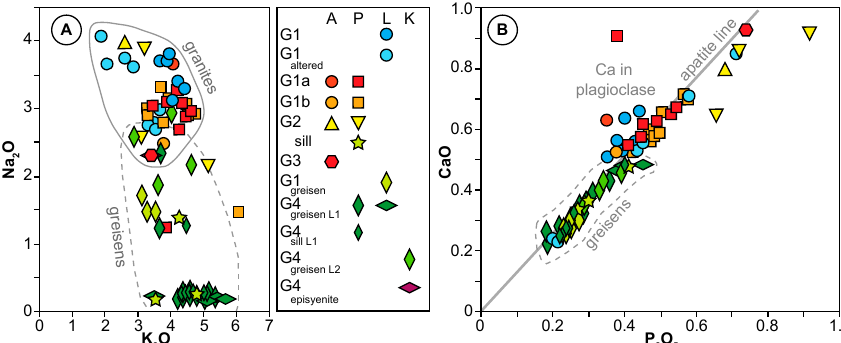
Figure 24. Major element geochemistry of the Panasqueira granite suite. ( A ) Na 2 O vs. K 2 O diagram, showing the sodium leaching in the greisens. ( B ) CaO vs. P 2 O 5 diagram, showing that calcium is essentially sequestered in apatite. Note that there is less apatite in greisens than in granites. A: [17], P [16], L [15], K